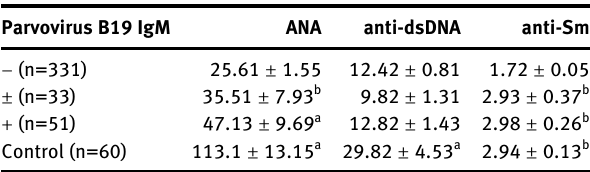
Table  : The level of autoantibodies in Parvovirus B  infected